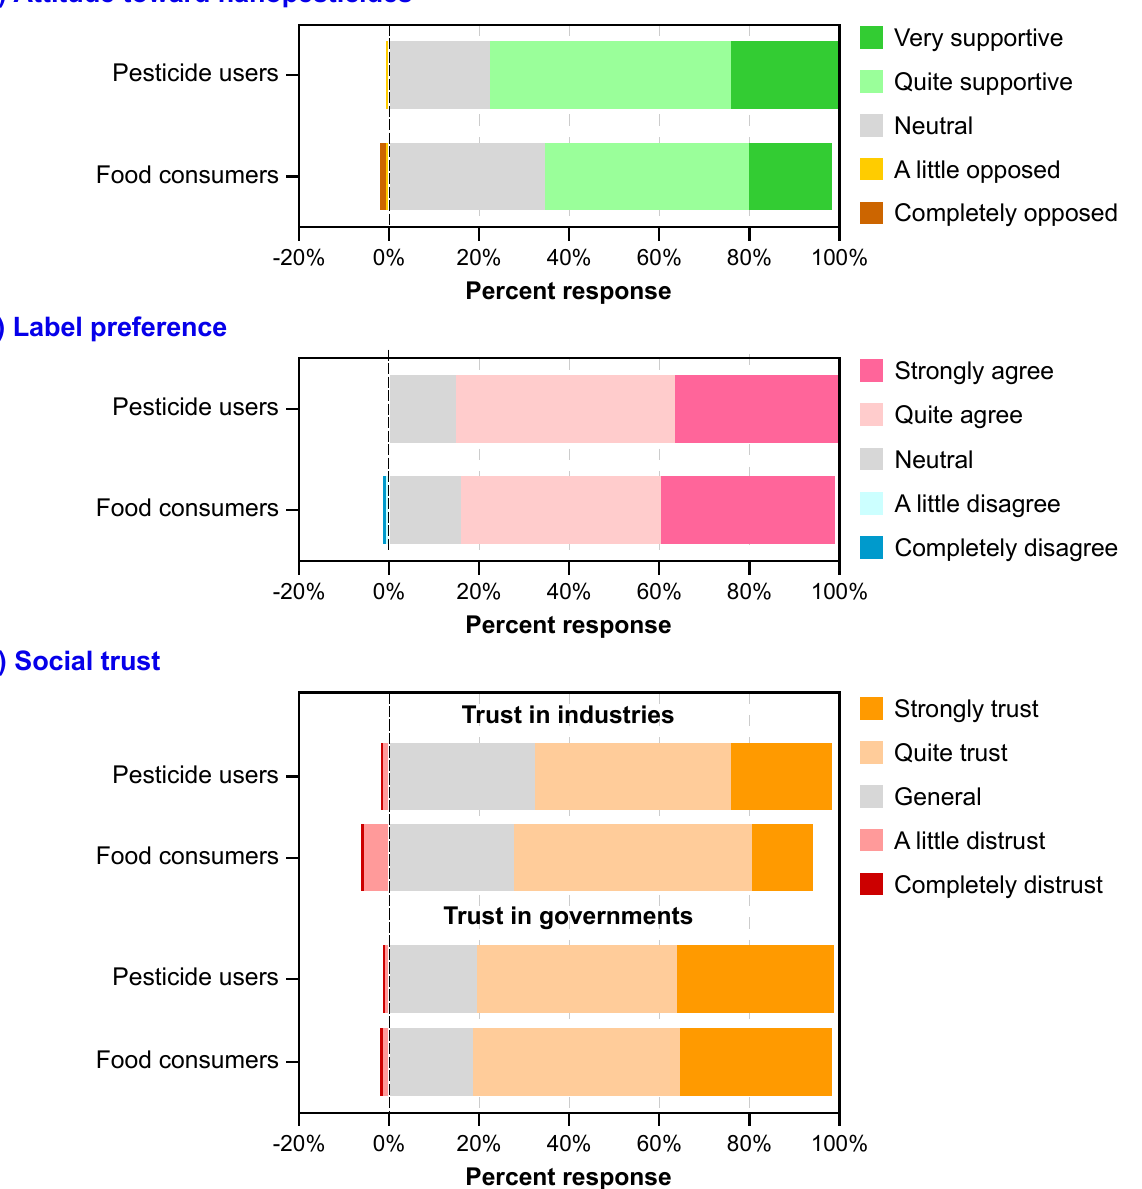
Figure 3. Comparison of public’s perspectives on nanopesticides between pesticide users (i.e., farmers) and food consumers (i.e., people from aquaculture and animal husbandry). Public responses when asked ( a ) “How familiar are you with nanopesticides?”; ( b ) “What is your attitude toward the future development of nanopesticides?”; ( c ) “Do you agree that the product label of nanopesticides must indicate that it contains nano-components?”; ( d ) “Do you trust that industries (manufactures and retailers) could produce and sell nanopesticides legally?” and “Do you trust that governments could supervise the safety risks of